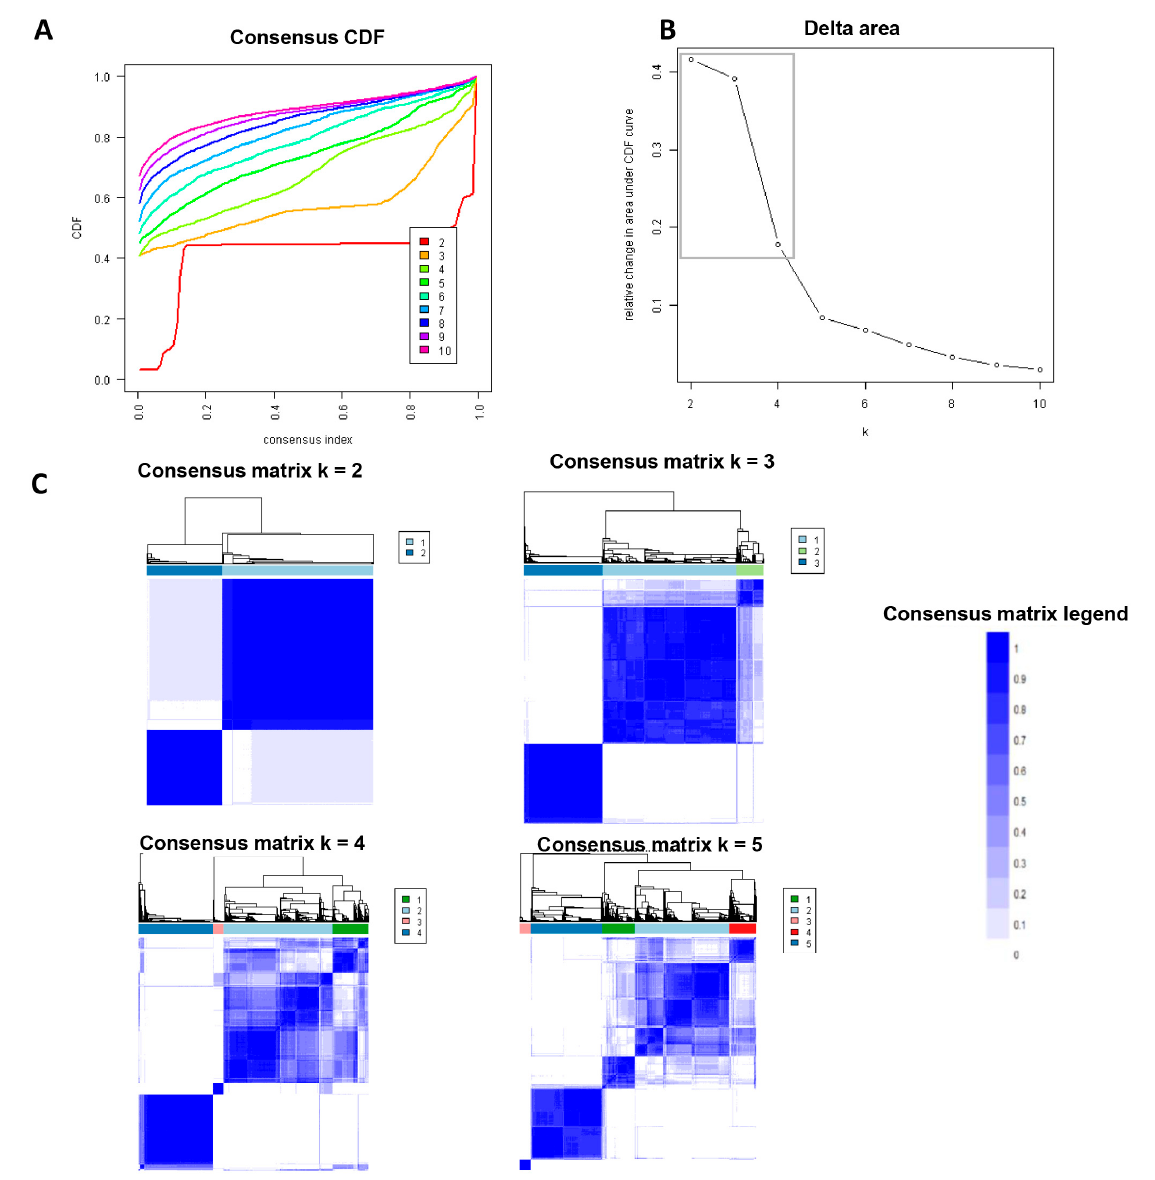
Figure 1. ( A ) Consensus CDF plot; ( B ) Delta area plot; ( C ) Consensus matrix heat map.